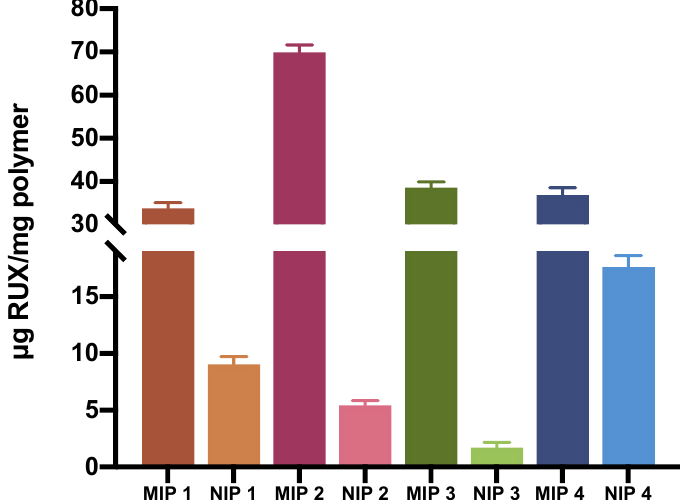
Figure 6. Comparison of LC of MIPs vs. RC of NIPs.